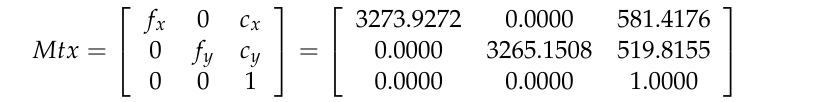
Figure 4. Checkerboard grid calibration diagram.